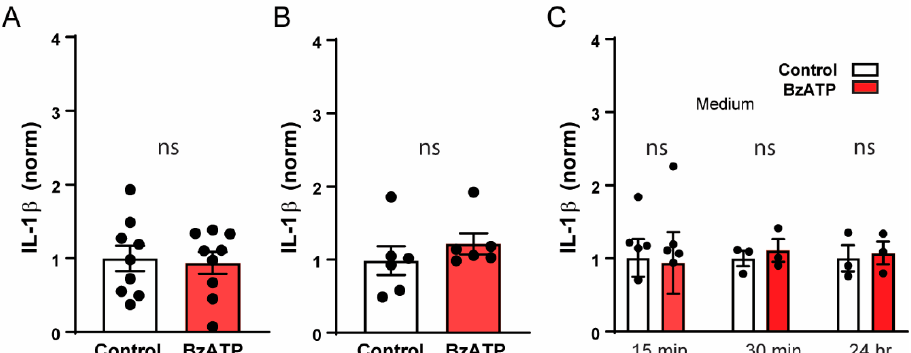
Figure 5. Stimulation of P2X7 receptor did not trigger release of IL-1 β from unprimed ARPE-19 cells. The levels of IL-1 β in the bath surrounding cells in control isotonic (white) and 50µM BzATP (red) solutions after 15 min ( A ; n = 9, p = 0.79) or 30 min ( B ; n = 6, p = 0.37). ( C ) Cells in growth media were incubated in BzATP for 15 min ( n = 6), 30 min ( n = 3) and 24 h ( n =3), but there was no rise in bath levels of IL-1 β . One –way ANOVA F(5,18) = 0.033, p = 0.9993.